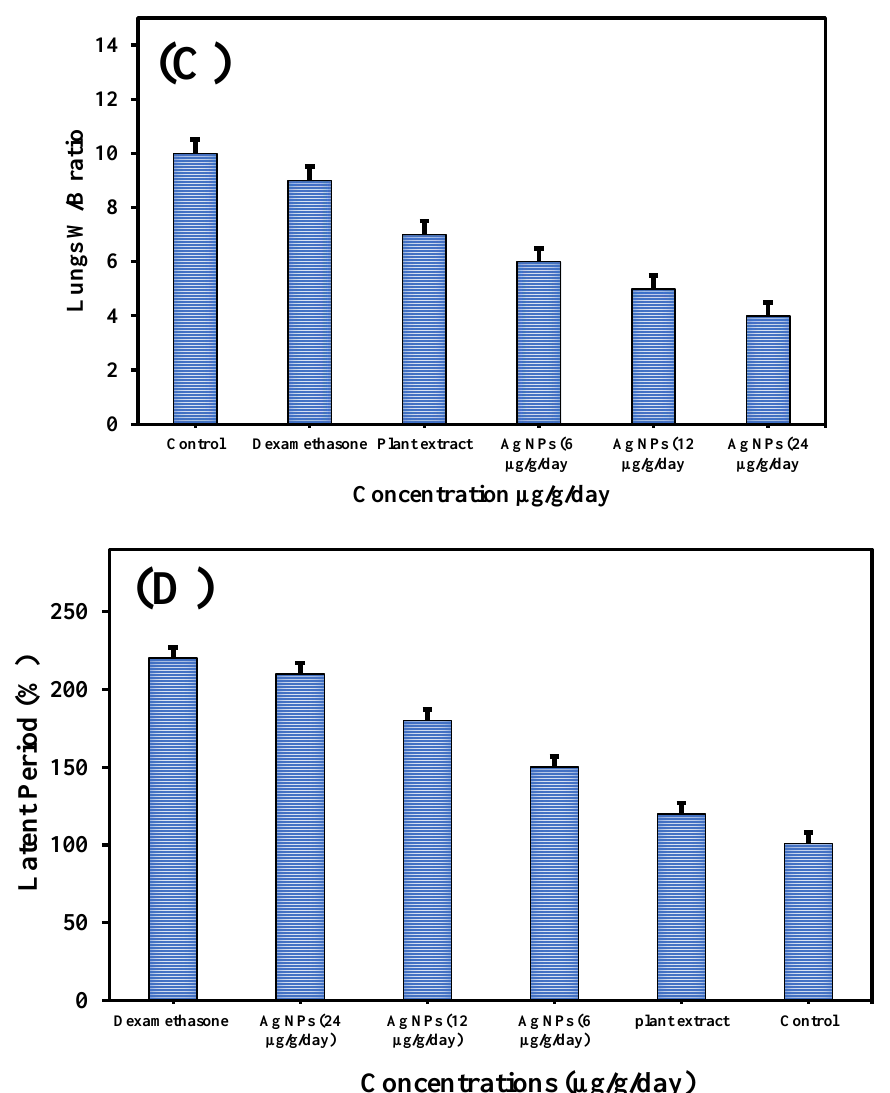
Figure 2. ( A ) Effects of the of Ag NPs on EOS Counts, ( B ) Effects of the Ag NPs on WBC Counts, ( C ) Effects of the Ag NPs on W/D Weight Ratio of Lungs ( D ) Effects of the Ag NPs on Latent Period (%).